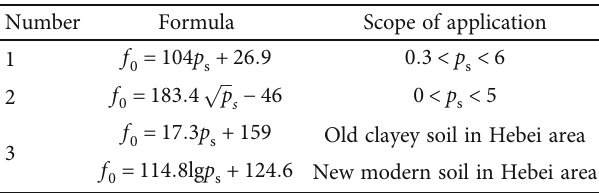
Table 2: Empirical formulas of static cone penetration test and foundation bearing capacity of cohesive soil.